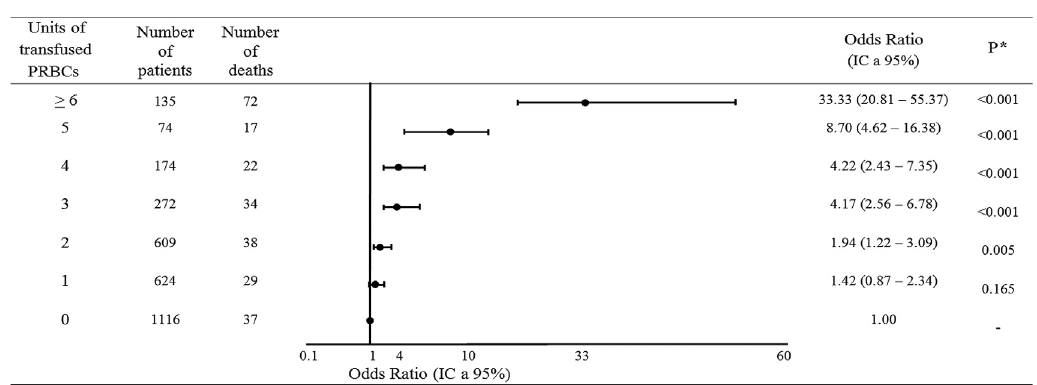
PRBCsFig. 2 - Univariate relationship between units of transfused PRBCs and subsequent 1 year mortality. PRBCs – packed red blood cells; CI – confidence interval; * probability’s descriptive level of the logistic regression